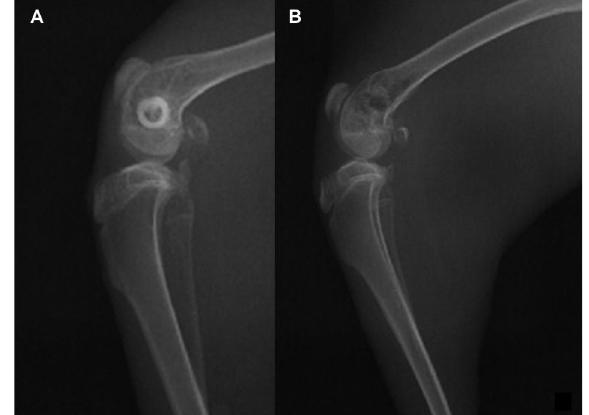
Figure 2. There was no sign of gas formation in the X-ray of New Zealand rabbit knee with the HA scaffold 2 weeks after implantation ( A ). There were signs of gas formation in the x-ray of New Zealand rabbit knee with the Mg scaffold 2 weeks after implantation ( B ).